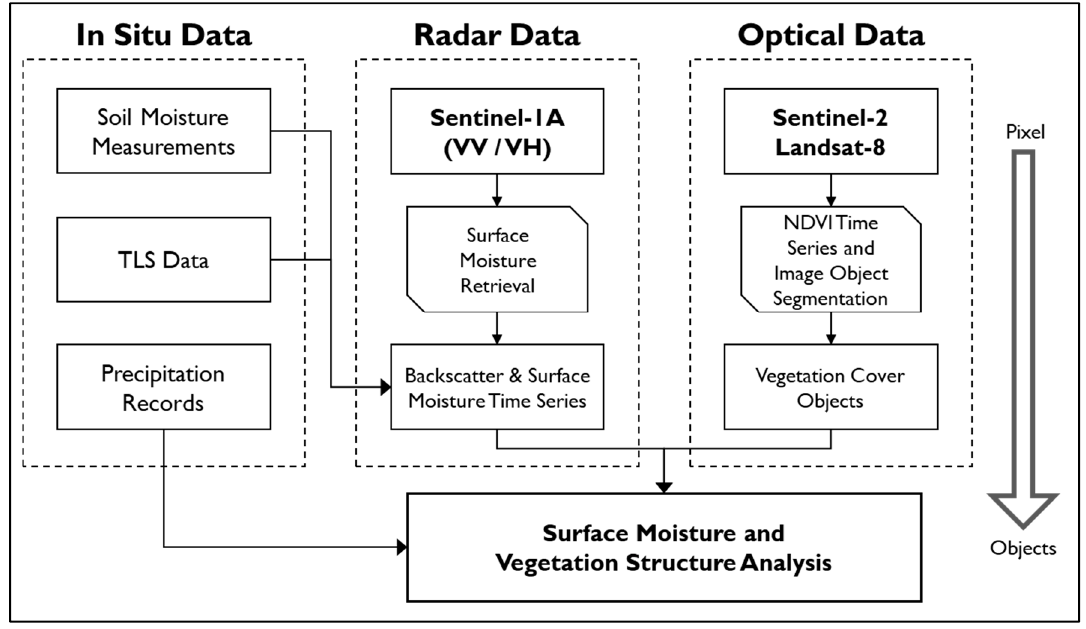
Figure 4. Methodological framework for the retrieval of a surface moisture index from radar time series, as well as vegetation information and dynamics from optical earth observation data.